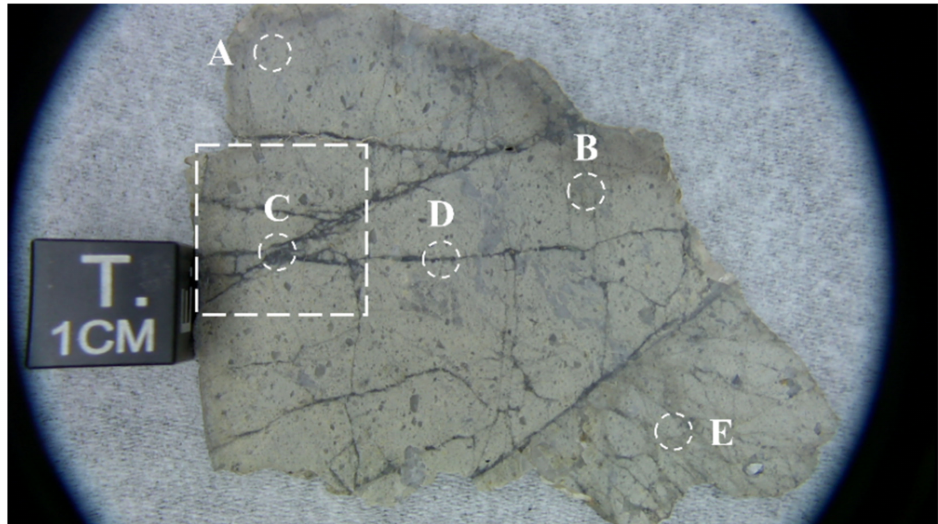
Figure 1. Photograph of lunar meteorite Northwest Africa 8687 and the location of point spectral measurements ( A – E ) in this study. The frame shows the rough location of the polished thin section for the petrographic